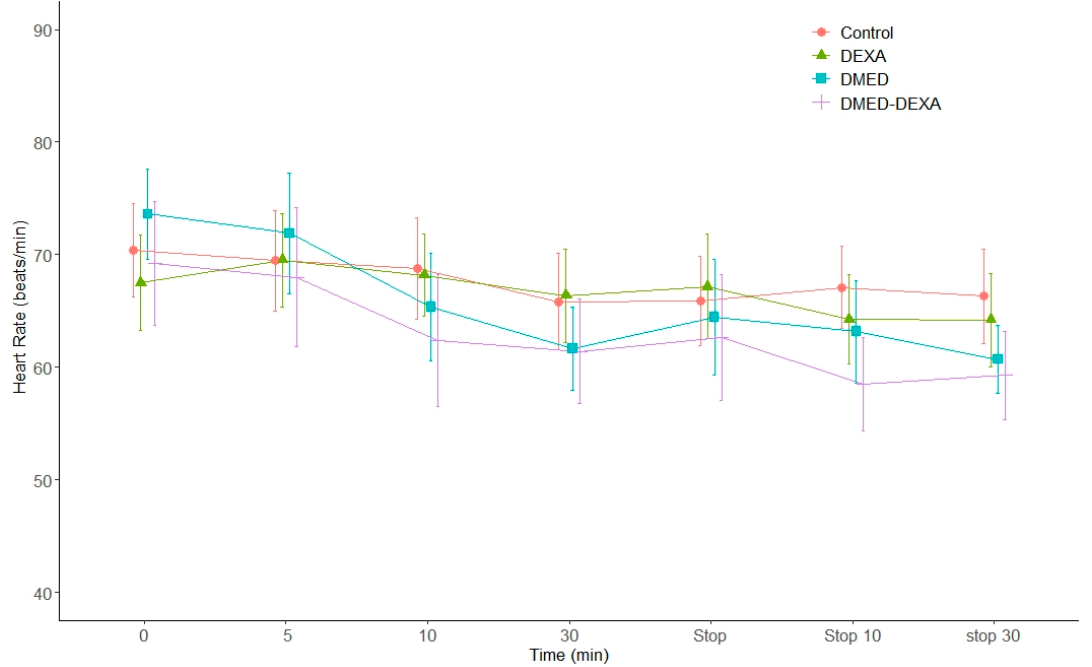
Figure A4. Changes in heart rate during and after surgery in the four study groups. The heart rate recorded at 0, 5, 10, and 30 min after the start of sedation and 0, 10, and 30 min after the end of sedative infusion. Table A3. The results of mixed-effect models for the repeatedly measured outcomes. mRSS: modi- fied Ramsay Sedation Scale, SBP: systolic blood pressure, HR: heart rate. * Asterisk indicates inter- action between the two factors (group and time). p Value